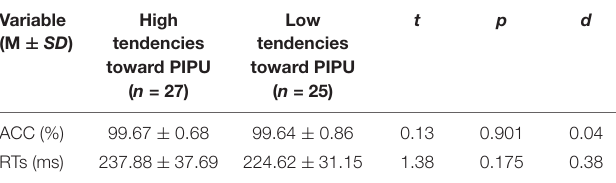
TABLE 2 | Descriptive statistics for accuracy and RTs measures for the target identification for each